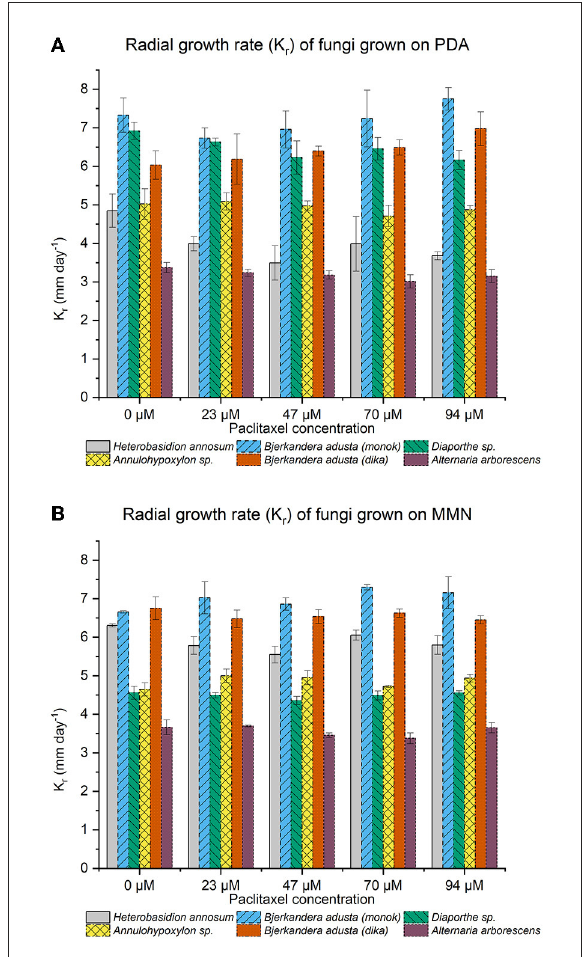
FIGURE3 (A,B) Radial growth rate (K r ) for fungi grown at increasing concentrations of paclitaxel in potato dextrose agar (PDA) or Minimal Melin Norkrans (MMN) media. The radial growth rate [K r = (radius 1 -radius 0 )/(time 1 -time 0 )] was calculated as a linear regression (Trinci, 1971). The fungi displayed different radial growth rates, which remained fairly constant when grown in either medium, regardless of the concentration of paclitaxel used. However, the radial growth rate for H. annosum was lower when grown in PDA, while Diaporthe sp. strain PAR5 showed a decrease when grown in MMN. Only the days corresponding to the exponential growth phase (Days 2–5) were included in the calculations. The bars indicate the standard